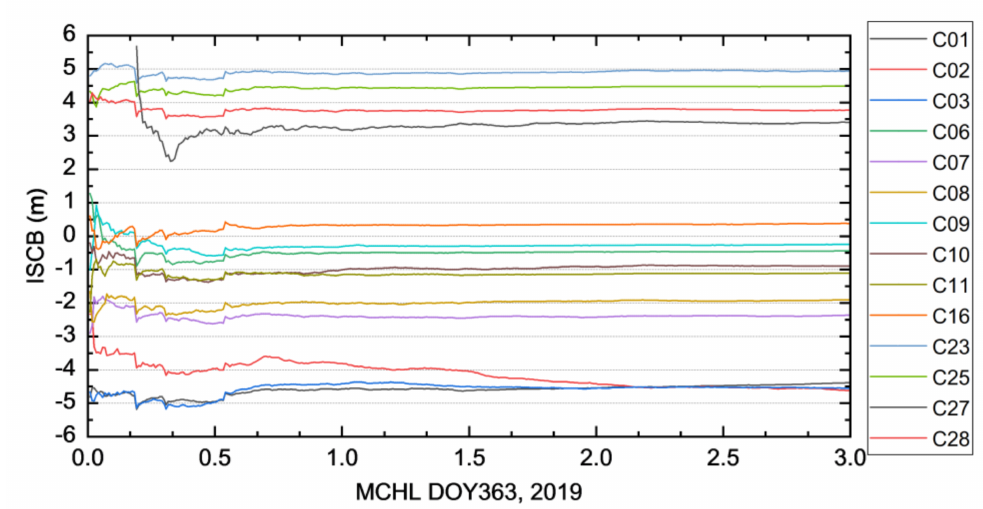
Figure 6. Time series of the BDS, 2 and BDS, 3 ISCBs for the MCHL station in the first three